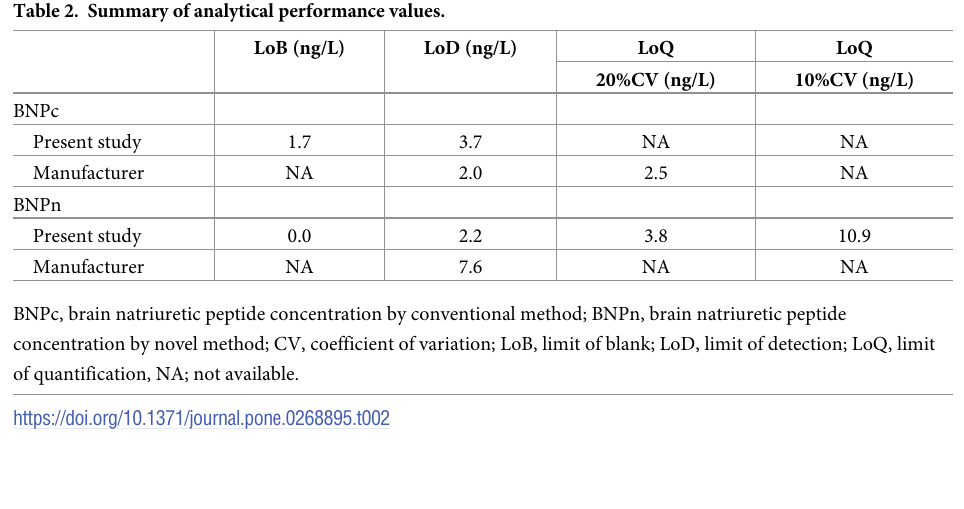
Table 2. Summary of analytical performance values.